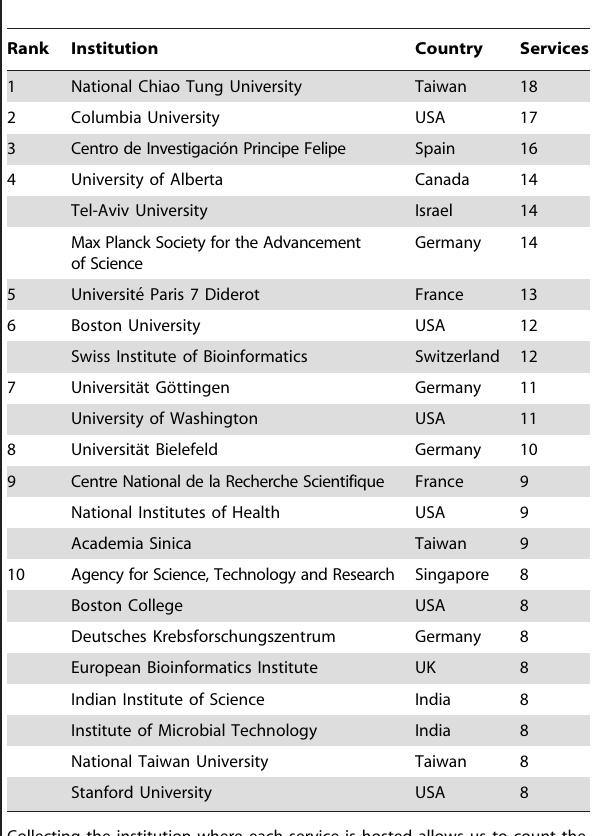
Table 3. Number of services hosted by a single institution. Table 4. Properties and Features Considered for the Usability